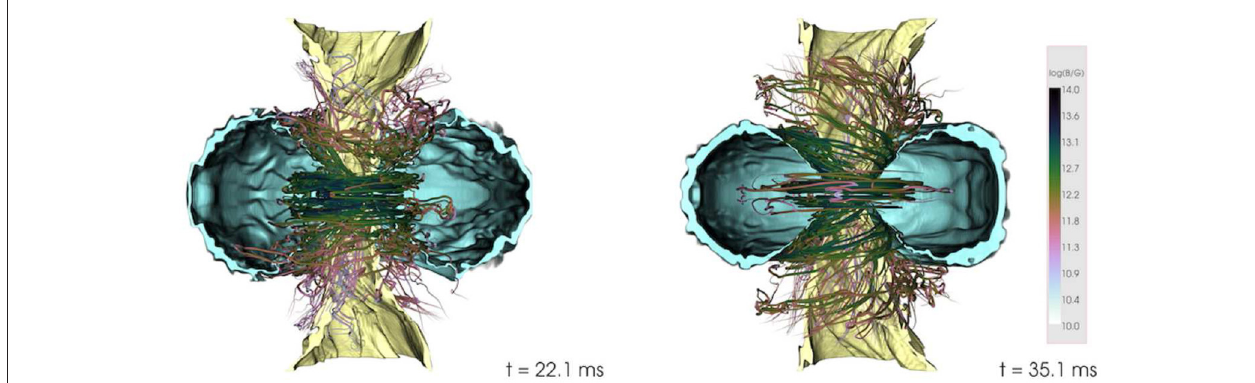
FIGURE 10 | Magnetic field lines at ∼ 22ms (left) and ∼ 32ms (right) following an NSNS merger, along with two isosurfaces of rest-mass density 10 8 (yellow) and 10 10 g / cm 3 (cyan), cut off for y < 0 (from Kawamura et al.,